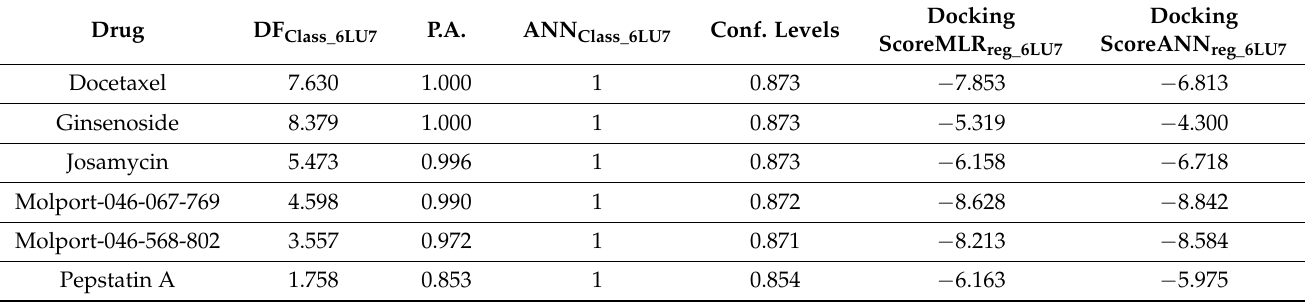
(Figure 2A). Of all potential anti-SARS-CoV-2 compounds selected by Molecular Topol- ogy stands Molport-046-067-769 as the one with higher binding affinity for 6LU7 binding pocket (docking score: − 7.514) (Figure 8), closest to co-crystallized ligand inhibitor N3 (docking score: − 8.019). This compound establishes interactions with four of the five amino acids (AAs) with which the co-crystallized ligand interacts with Mpro (Inhibitor N3) named Thr26, Gln189, Glu166, and Gly143 (Table 6). All AA interactions with Mpro binding pocket from all reported potential anti-SARS-CoV-2 are reported in Table 6. Table 6. Potential anti-SARS-CoV-2 compounds selected by Molecular Topology and docking score for Mpro (PDB:6LU7). Interaction with Indicated Table 5. Six drugs selected by the Molecular Topology strategy as potential anti-SARS-CoV-2. Compound Docking Score Amino Acids